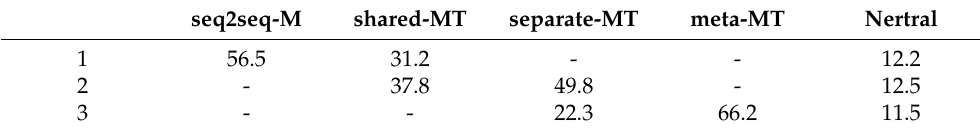
Table 2. Subjective AB preference score(%) of synthesized Mandarin speech samples with p < 0.01.